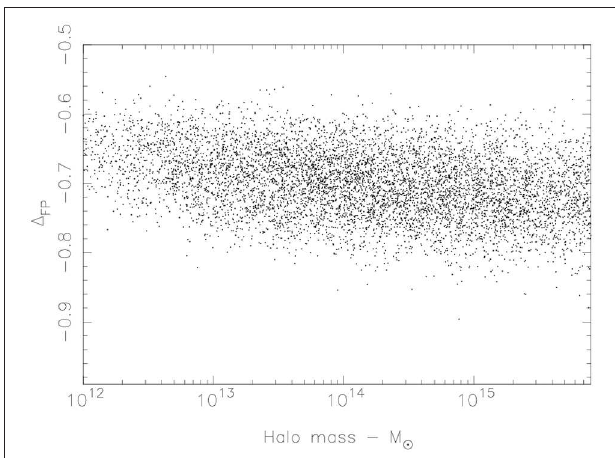
FIGURE 5 | Deviation from the virial plane vs. halo mass. The tilt is reduced by an order of magnitude from Figure 2 .